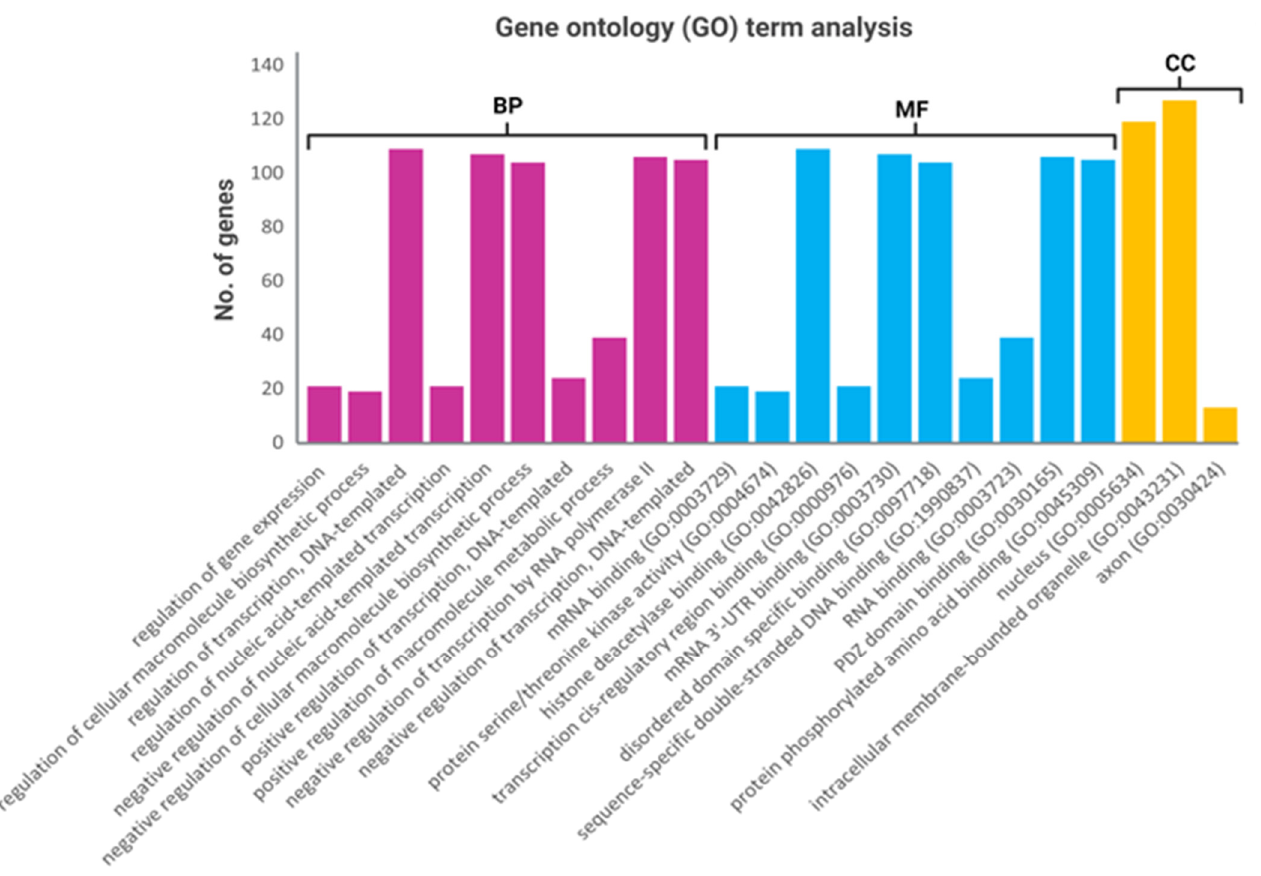
Figure 6. GO analysis of predicted target genes regulated by miR-151a-3p and miR-199a-3p. Data are presented as the number of genes (Y-axis) involved in each of the domains. The X-axis represents GO terms of each biological process (BP, purple bar), molecular function (MF, blue bar), and cellular component (CC, yellow bar) (X-axis) with FDR adjusted p -value < 0.05 (Benjamini–Hochberg) .